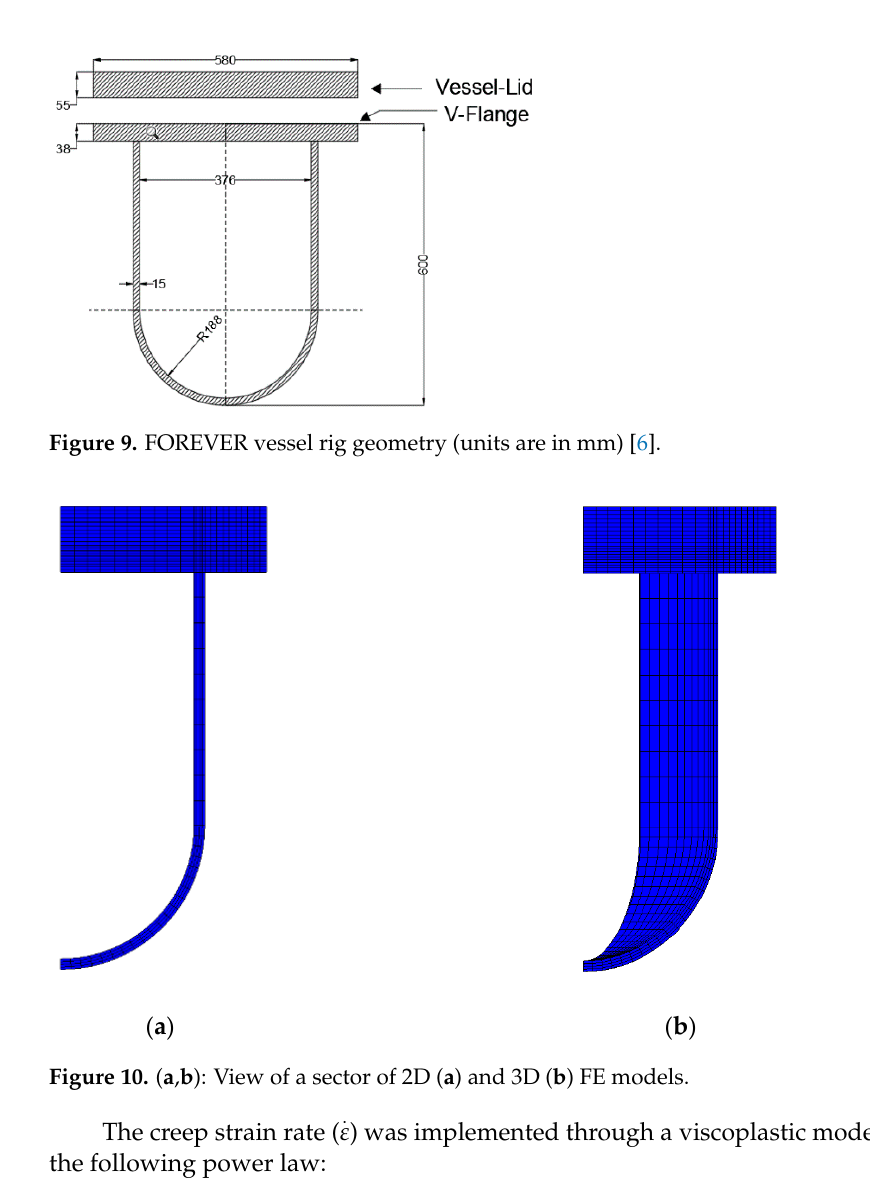
Table 1. Power law coefficients